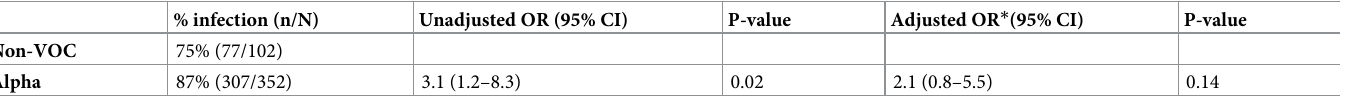
Table 5. Unadjusted and adjusted odds ratios for the effect of index case Alpha variant SARS-CoV-2 on household contact infection (defined as either anti-nucleo- capsid IgG seropositivity or anti-spike IgG seropositivity in an unvaccinated individual) compared to non-VOC SARS-CoV-2. % infection